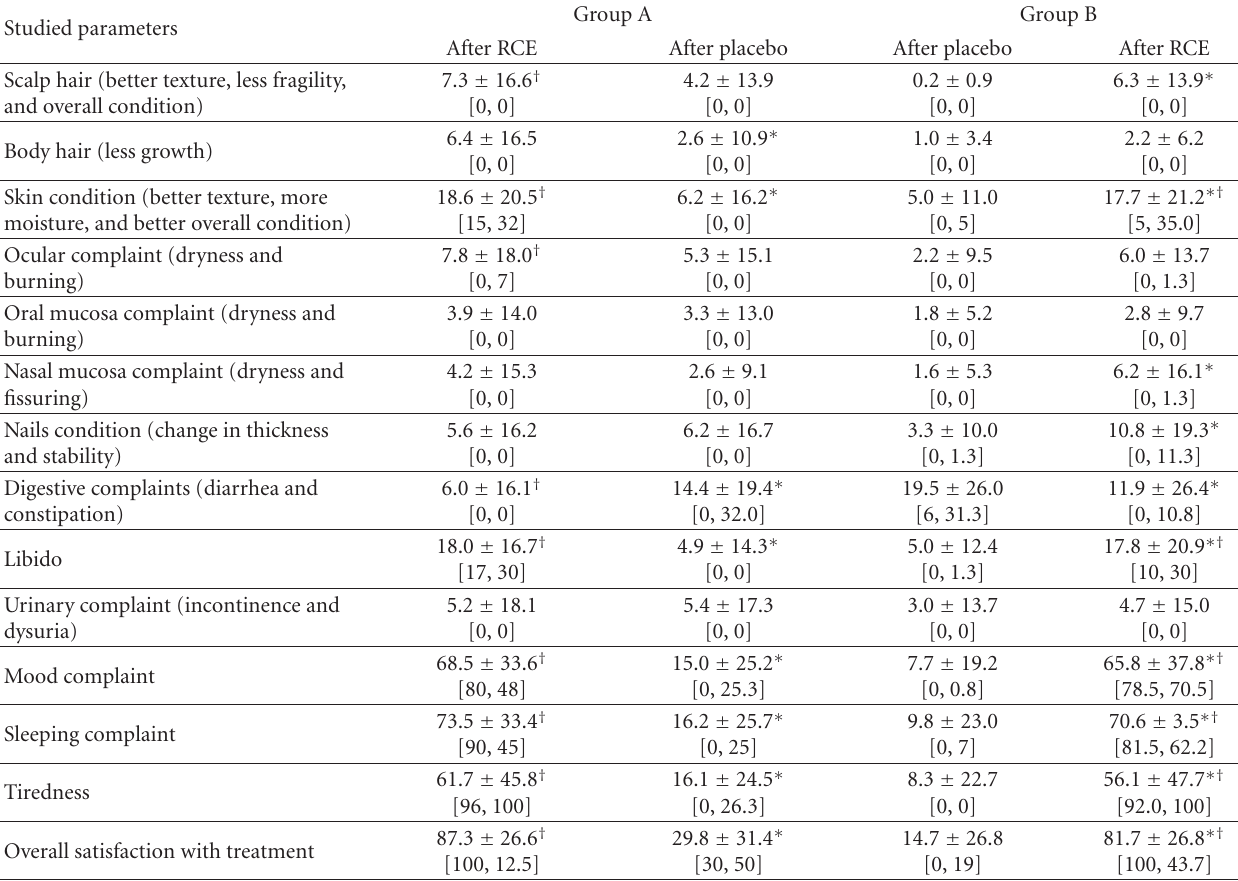
Table 2: Subjective symptom or condition improvement after treatment as assessed with the